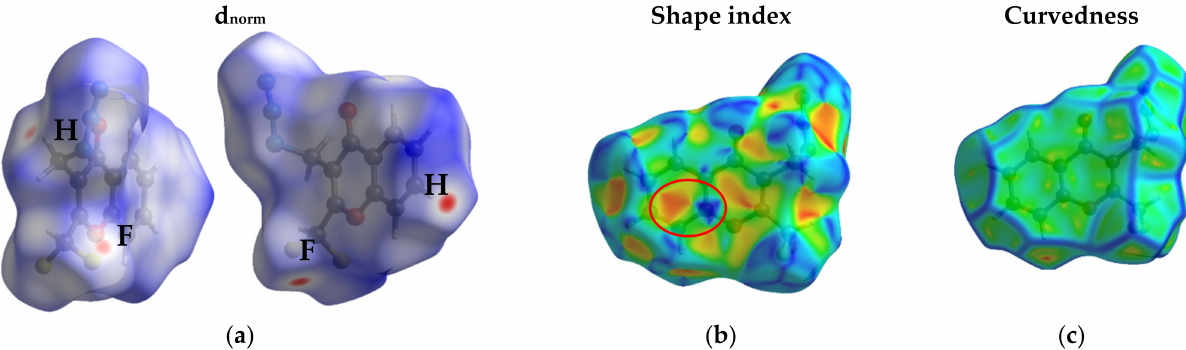
Figure 3. Hirshfeld surfaces mapped over d norm ( a ), shape index ( b ) and curvedness index of 4 ( c ).